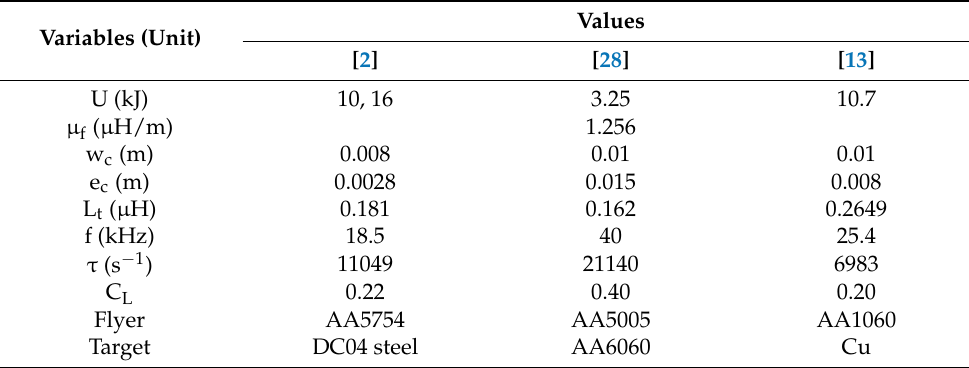
Table 6. Values used for calculation of the EM pressure (p) for MPW of sheets. Variables